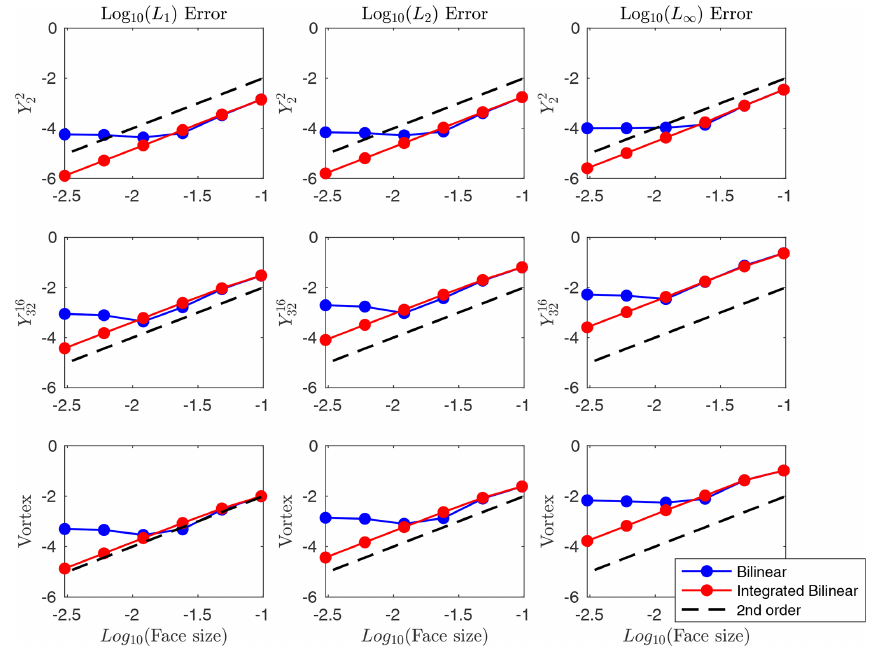
Figure 13. Convergence results for the integrated and non-integrated bilinear remapping schemes from cubed spheres to a fixed latitude– longitude